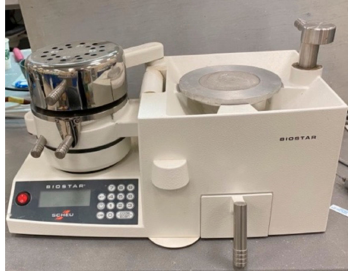
Figure 2. BioStar VI vacuum forming